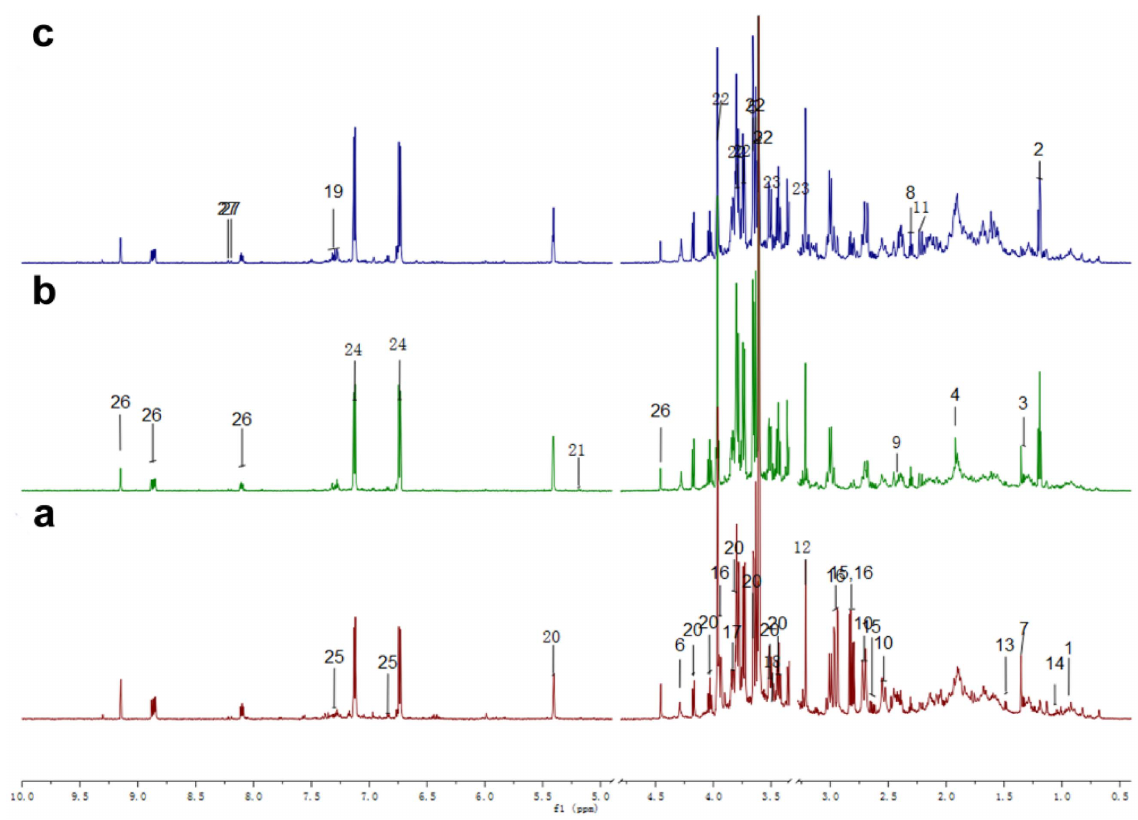
Figure 1. Typical 1 H NMR spectra of leaves. a, 1 H NMR spectra of leaves from control plants for 12 h; b, 1 H NMR spectra of leaves from seedlings infested for 12 h; c, 1 H NMR spectra of leaves from seedlings exposed to HIPVs for 12 h. 1: a -Linoleic acid analogues, 2: ethanol, 3: threonine, 4: acetic acid, 5: oxalacetic acid, 6: glycolate, 7: a -hydroxyisobutyric acid, 8: glutaric acid, 9: succinic acid, 10: citric acid, 11: acetone, 12: choline, 13: alanine, 14: valine, 15: aspartic acid, 16: asparagin, 17: serine, 18: glycine, 19: phenylalanine, 20: sucrose, 21: a -Glucose, 22: pinitol, 23: inositol, 24: hydroxybenzene derivative 1, 25: 4-hydroxyphenylacetic acid, 26: trigonelline, 27: adenine.